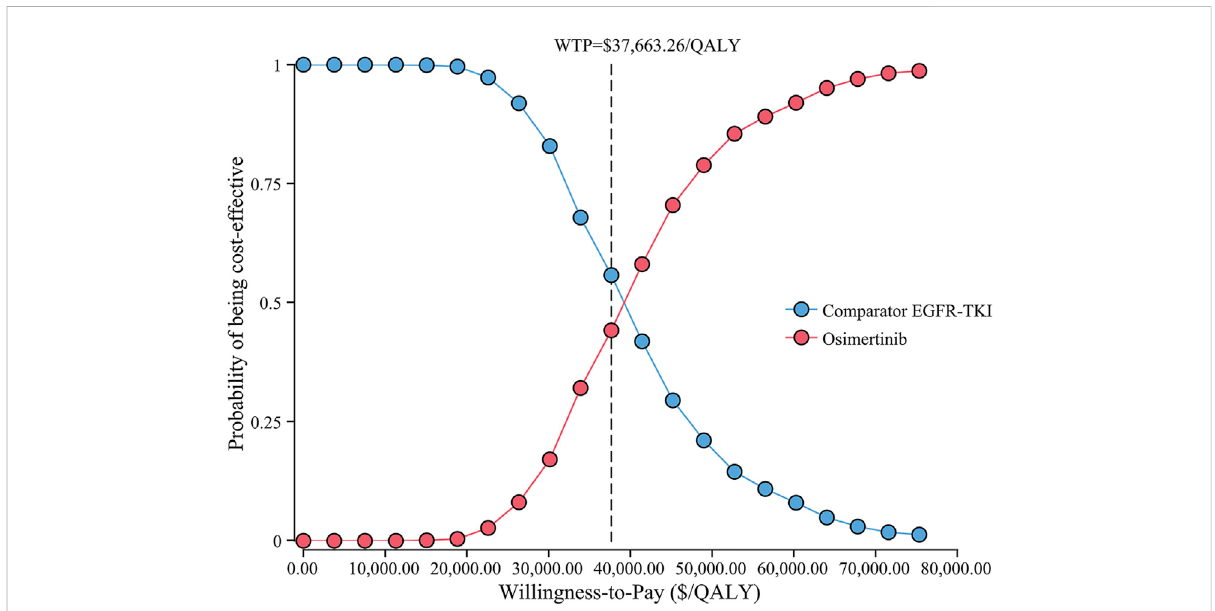
FIGURE 4 Cost-effectivenessacceptabilitycurveforosimertinibversusthecomparator EGFR-TKI. Abbreviations:QALY,quality-adjustedlife-year;EGFR- TKI, epidermal growth factor receptor – tyrosine kinase inhibitor; WTP, willingness-to-pay.